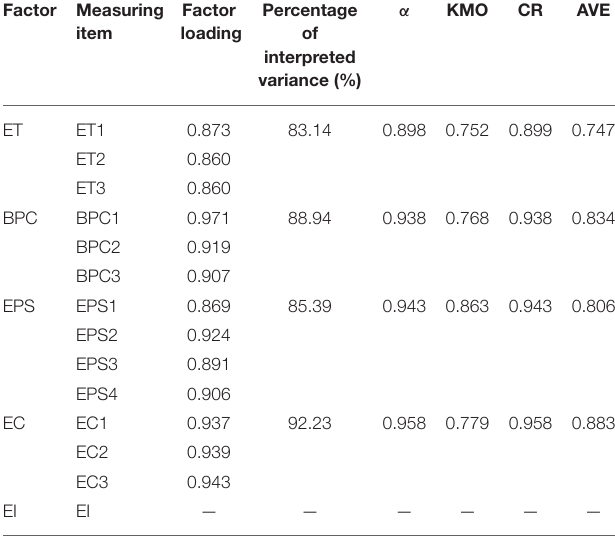
TABLE 2 | Reliability and validity of each factor.